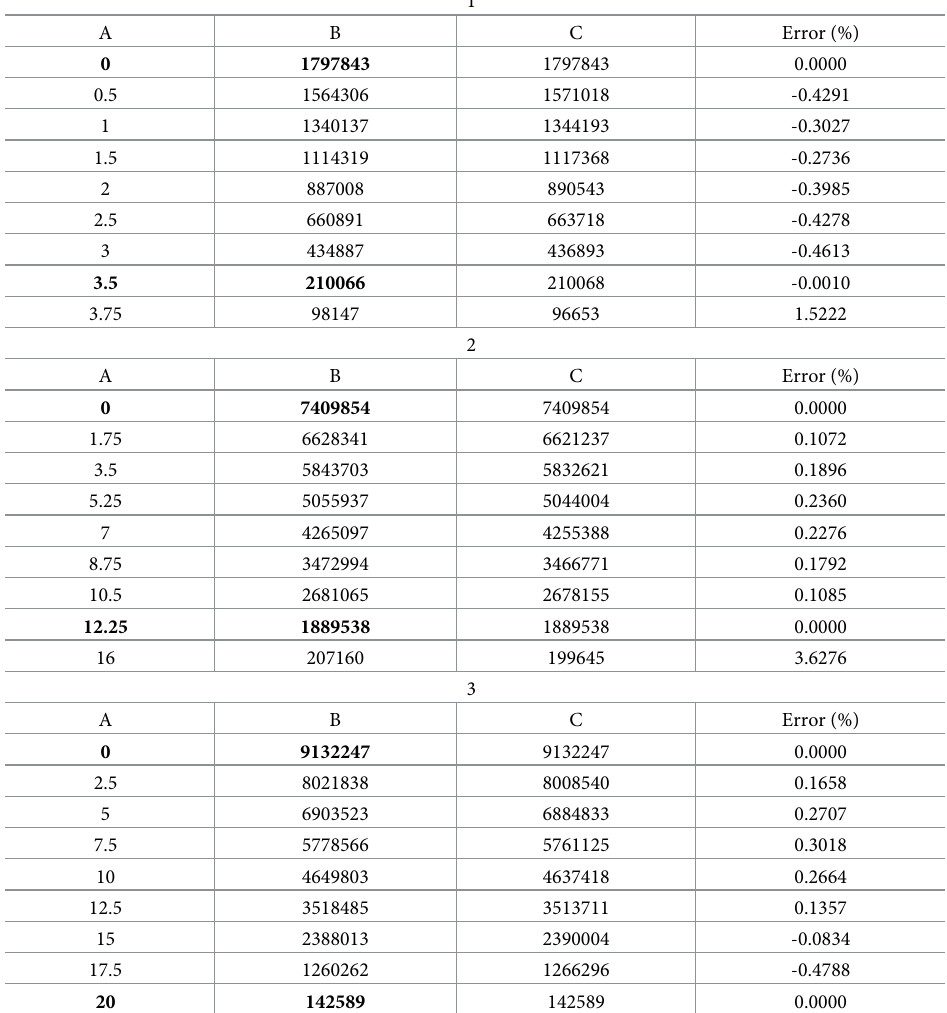
(a) Single cluster. Average of the absolute value of the error in the above range is 0.4072%. The maximum of the absolute value of error in 3.75–4 million range is 13.4121%, and is registered at 3.912 million. (b) Four cluster star topology. Average of the absolute value of the error in the above range is 0.9648%. The maximum of the absolute value of the error in 16–16.4 million range is 9.2907%, and is registered at 16.22